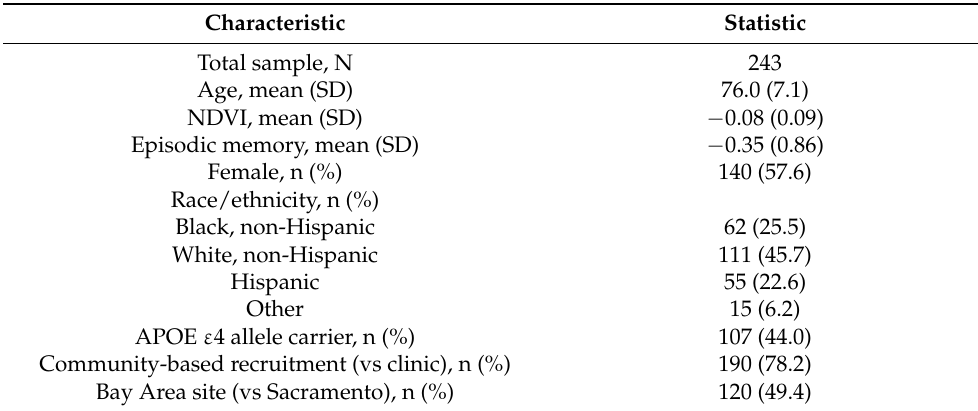
Abbreviation: NDVI, Normalized Difference Vegetation Index; SD, standard